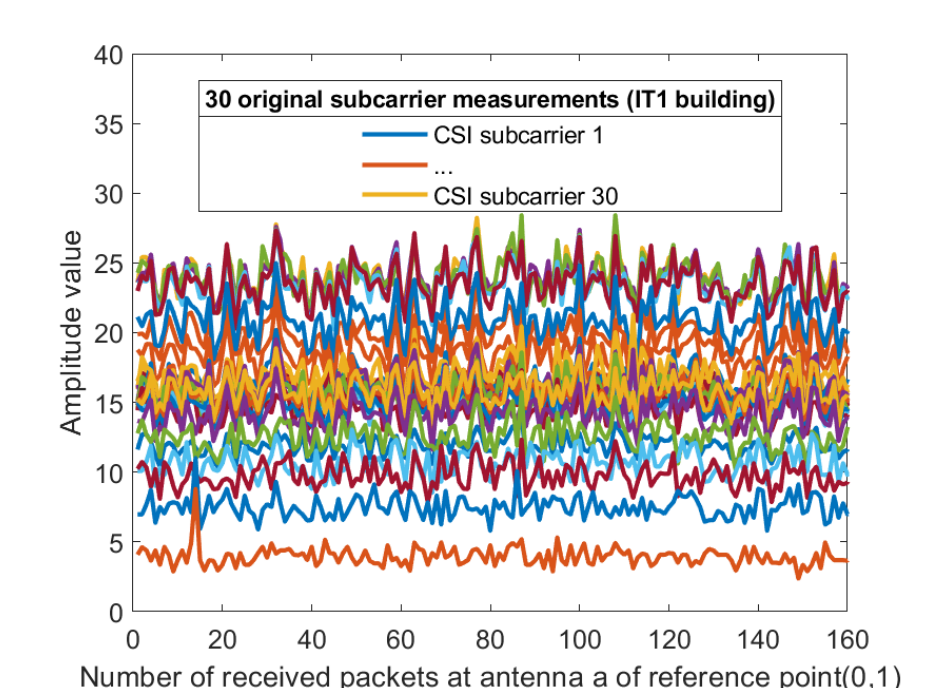
Figure 8. The amplitude of the 30 CSI sub-carriers on antenna a at reference point (0,1) of AP1 in the corridor of IT1 building.